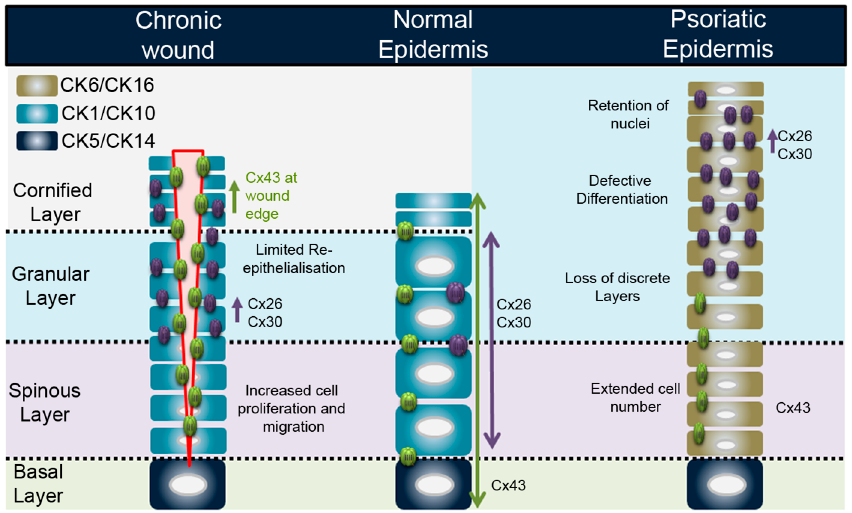
Figure 2. Connexin expression profile in the normal epidermis, at a chronic wound edge, and representative state in a psoriatic